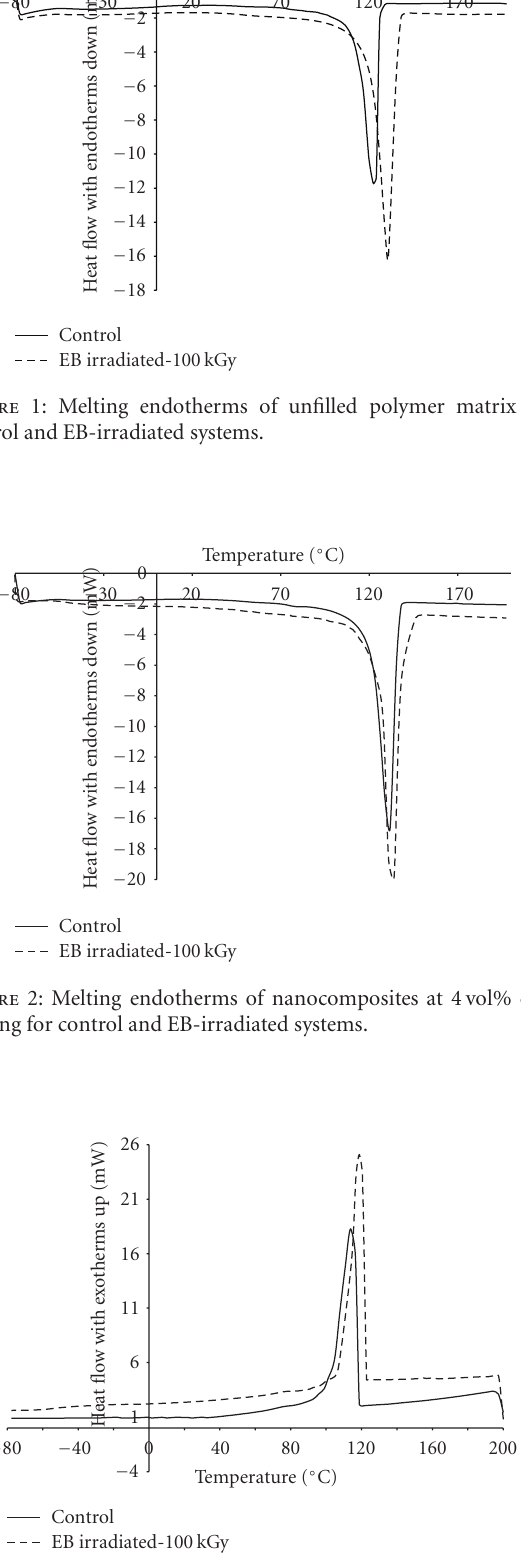
Figure 3: Crystallization exotherms of unfilled polymer matrix for control and EB-irradiated